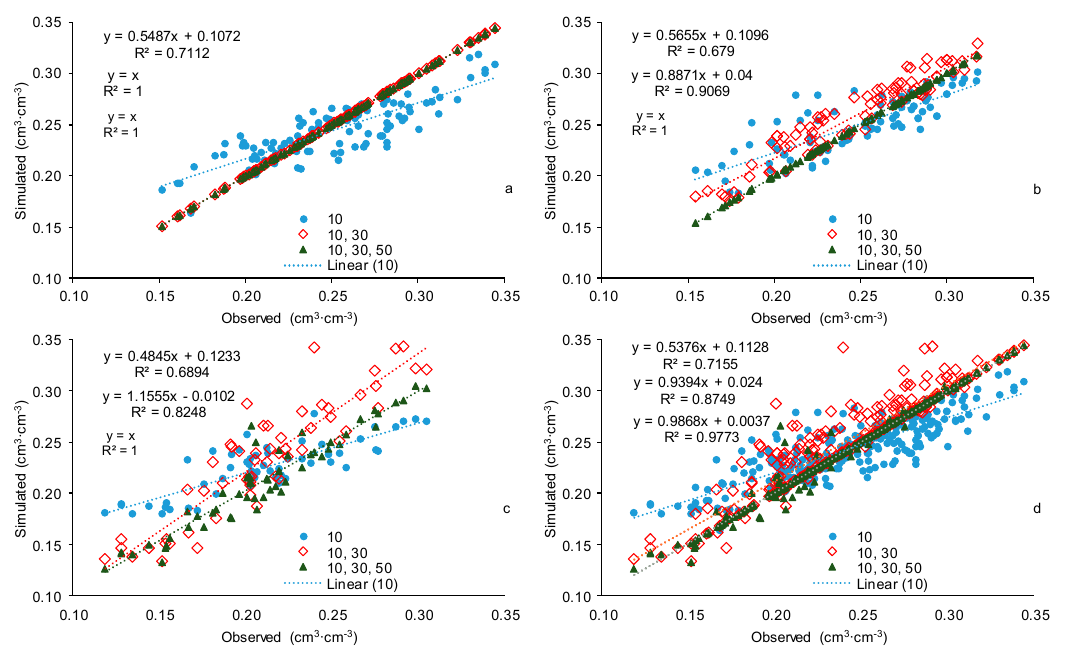
Figure 7. Validation results of simulated data with observed data: ( a ) early stage; ( b ) middle stage; ( c ) last stage; and ( d ) whole growing season of winter wheat.